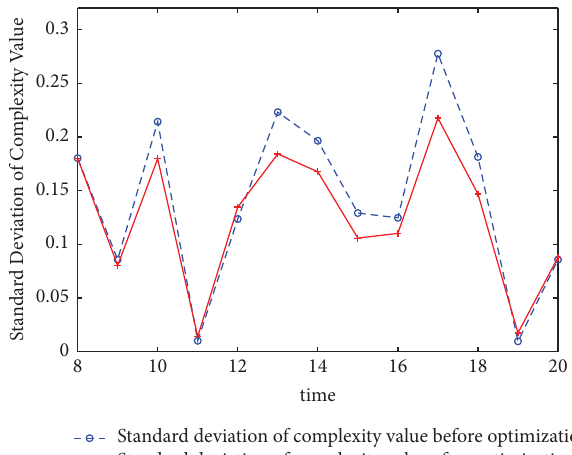
Figure 21: Changes in complexity standard deviation before and after